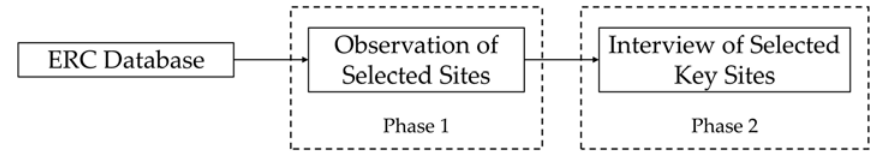
Figure 1. Data collection flow.